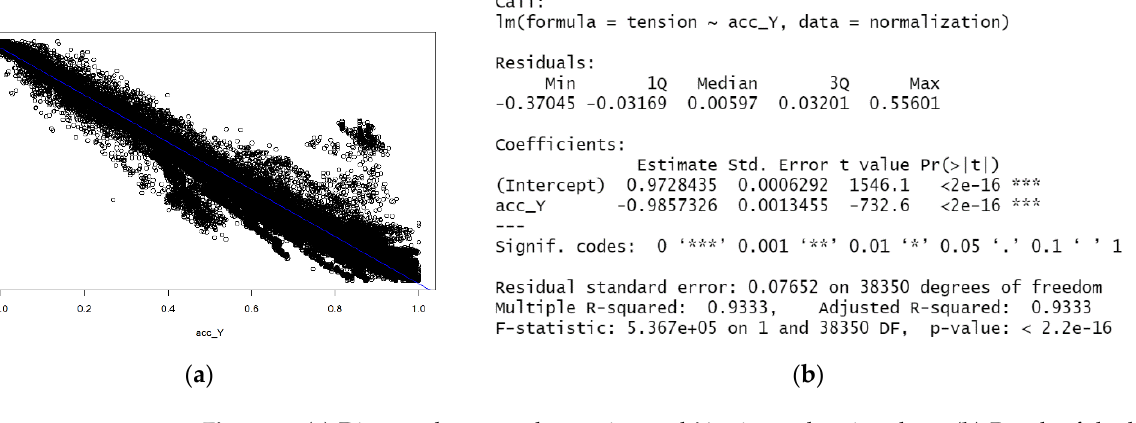
Figure 8. ( a ) Diagram between the tension and Y -axis acceleration data. ( b ) Result of the linear regression analysis using R.